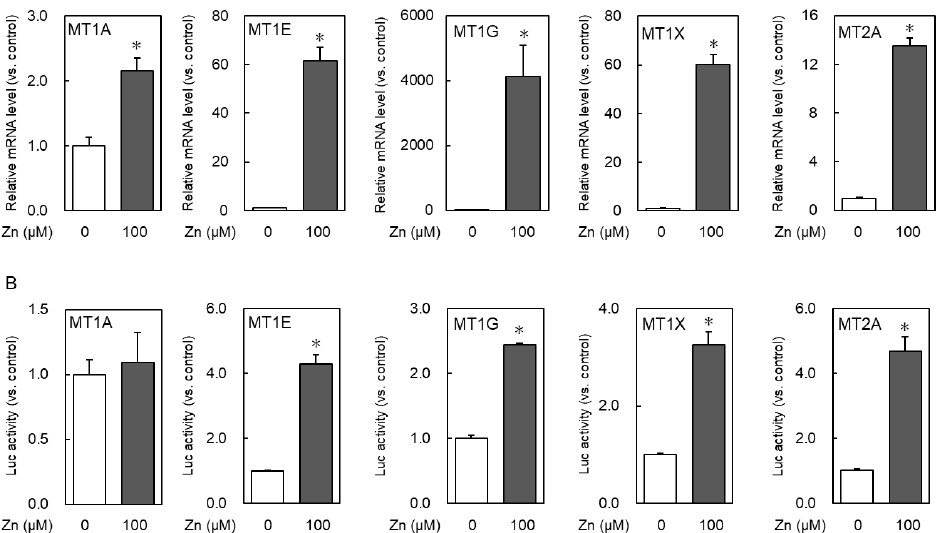
Figure 3. Each MT isoform expression after zinc treatment in 2-day zinc-deficient cultured cells. ( A ) HeLa cells, which were precultured for 2 days with zinc-deficient medium, were treated with zinc at the indicated concentrations for 6 h, and the MTs mRNA expression was determined via real-time RT-PCR. ( B ) The promoter activity after 6 h of zinc treatment was measured. The same vectors used in Figure 2 were used. * p < 0.05 indicates significant difference from the untreated group.